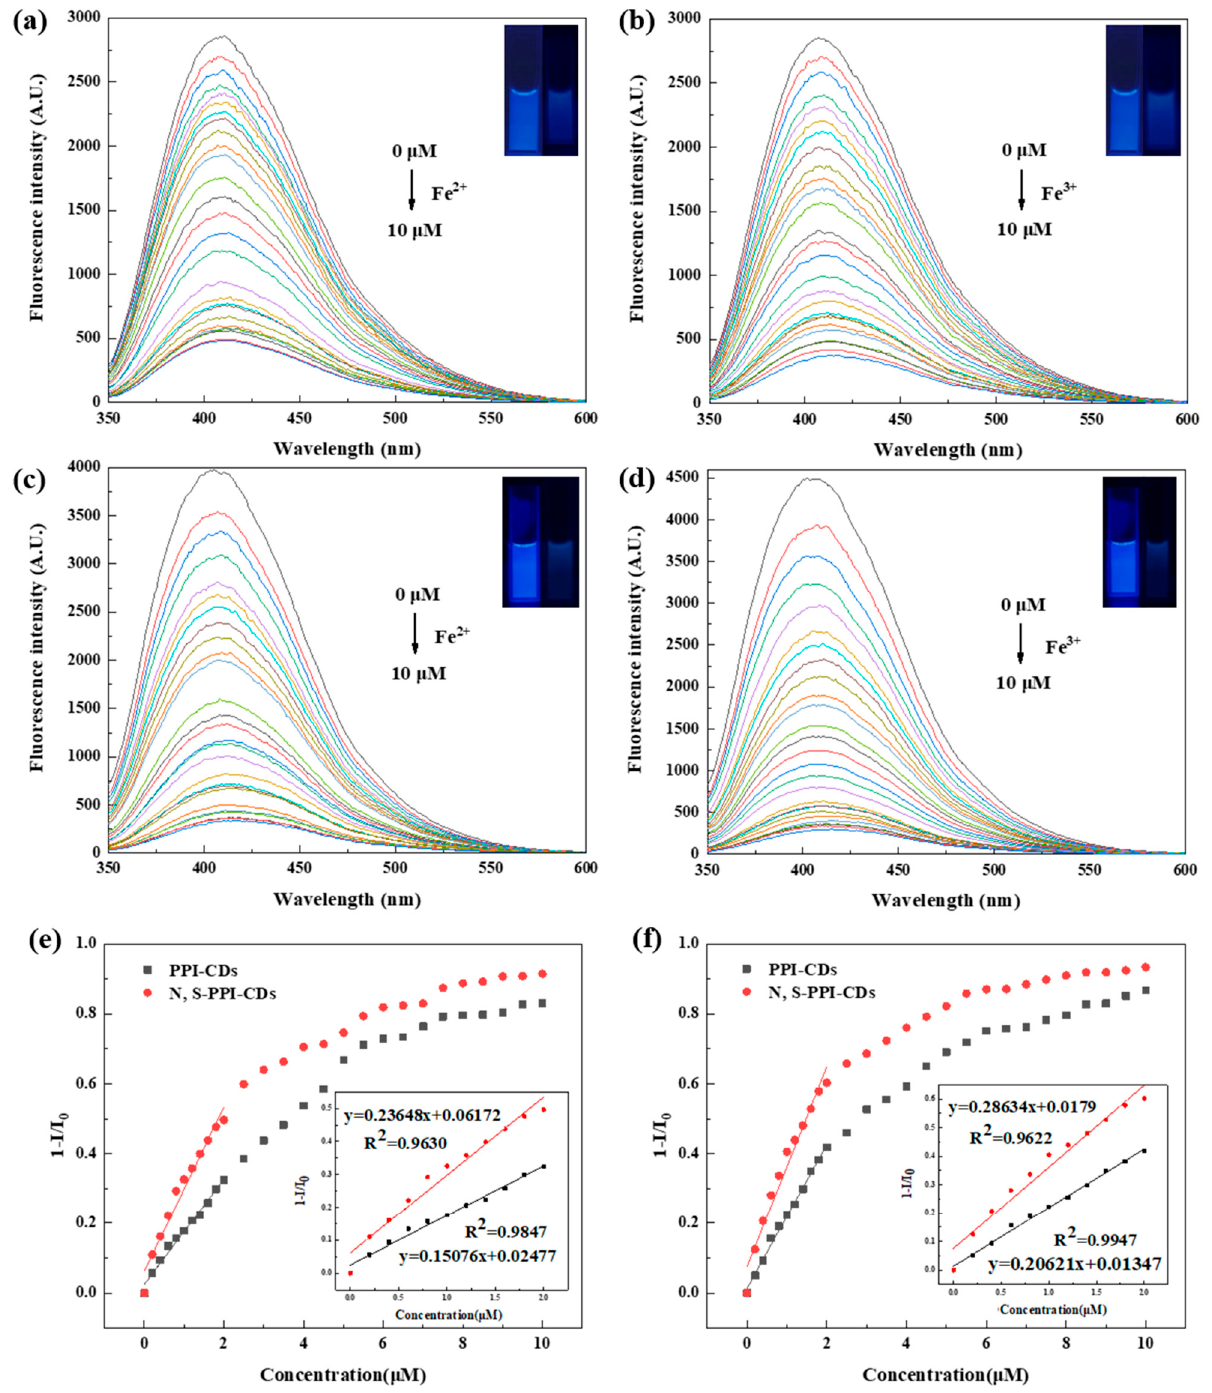
Figure 7. Fluorescence response of PPI-CDs with different concentrations of ( a ) Fe 2+ and ( b ) Fe 3+ (Inset: photographs of PPI-CDs solution under UV (365 nm) irradiation after adding Fe 2+ or Fe 3+ (0 and 10 µ M), respectively); fluorescence response of N, S-PPI-CDs with different concentrations of ( c ) Fe 2+ and ( d ) Fe 3+ (Inset: photographs of N, S-PPI-CDs solution under UV (365 nm) irradiation after adding Fe 2+ or Fe 3+ (0, 10 µ M), respectively); Stern–Volmer plots of PPI-CDs and N, S-PPI-CDs toward ( e ) Fe 2+ and ( f ) Fe 3+ , respectively.